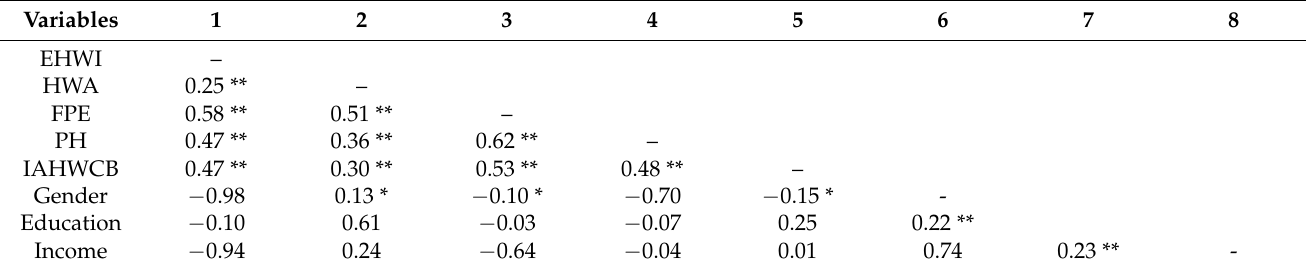
Table 2. Correlations matrix of key